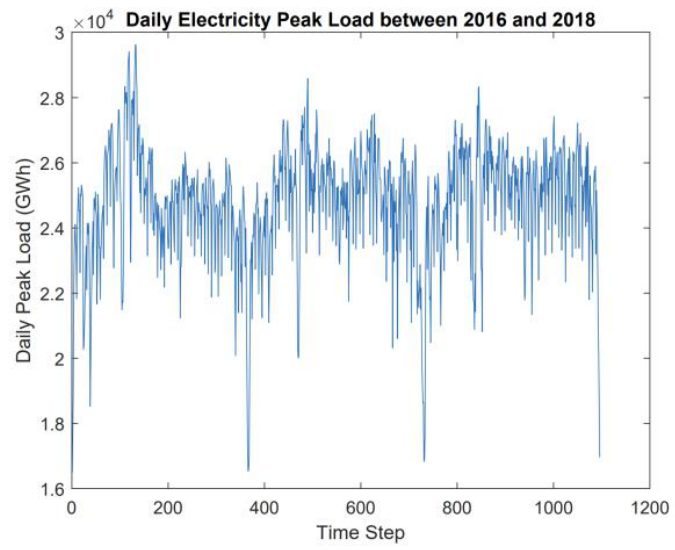
Figure 7. Daily electricity peak load between 2016 and 2018.